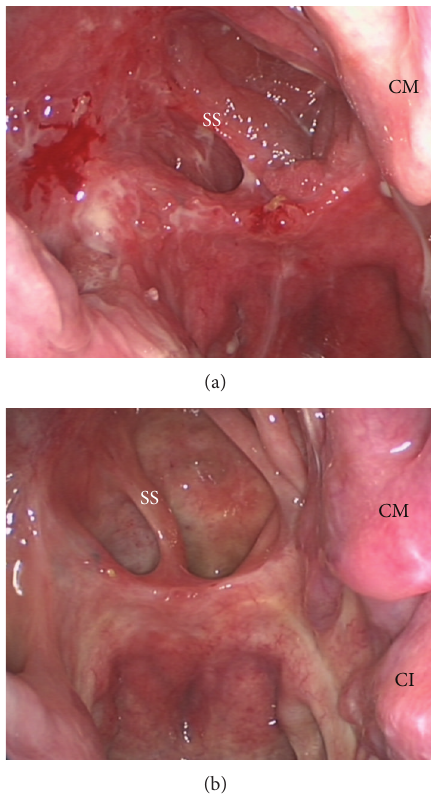
Figure 5: Endoscopic view of the operation field 3 months after surgery (a). No sign of recurrence. Twelve months after surgery (b), there is no sign of irritation. Concha inferior (CI), concha media (CM), and sphenoid sinus (SS).